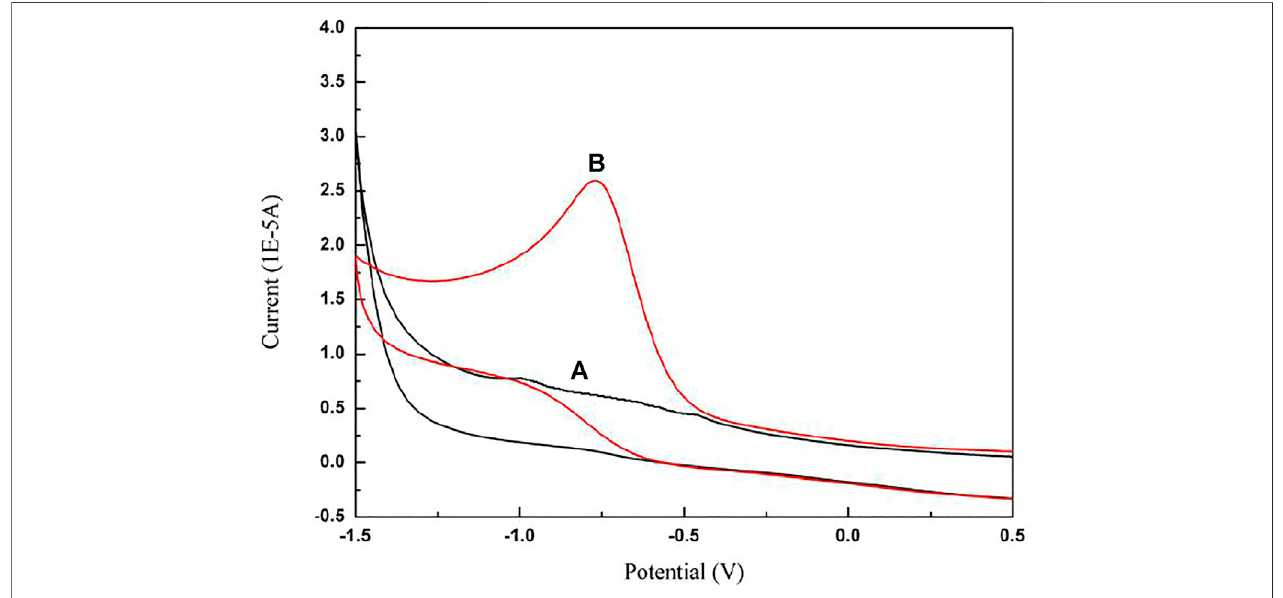
FIGURE 2 | Cyclic voltammograms of (A) 5.0 mol/L acetate buffer (pH 4.0) in the absence of paclitaxel, (B) 5.0 mol/L acetate buffer (pH 4.0) in the presence of paclitaxel (5 × 10 − 4 mol/L) at GCE; scan rate is 50 mV/s.